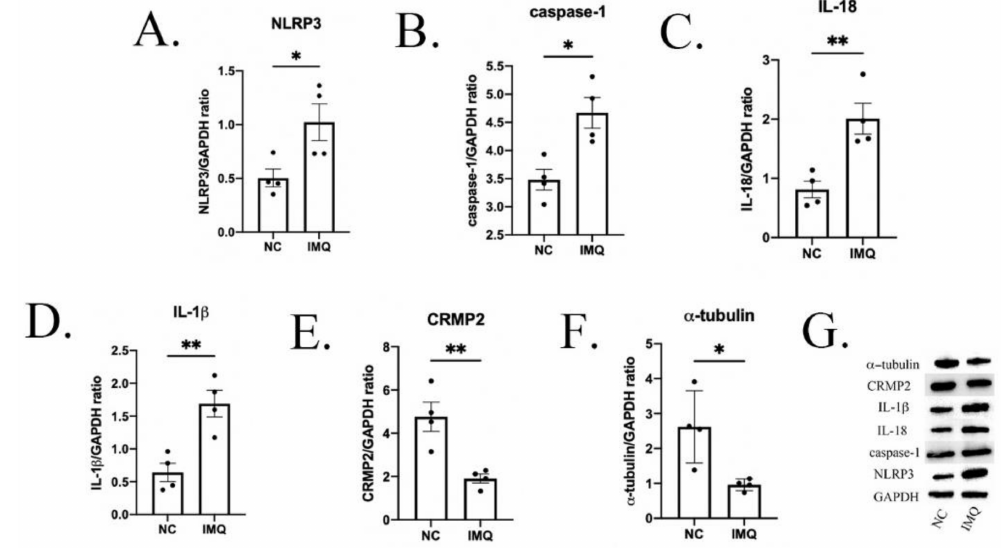
Figure 4. Hippocampal protein levels of neuroinflammation and neuroplasticity biomarkers in mice. Western blot analysis of ( A ) NLRP3, ( B ) caspase-1, ( C ) IL-18, ( D ) IL-1 β , ( E ) CRMP2, and ( F ) α -tubulin protein expression. ( G ) Densitometry analyses of the bands. Each value represents the mean ± SEM. n = 4 animals per group. Two groups (NC, IMQ) were analyzed using t -test (* p < 0.05, ** p <